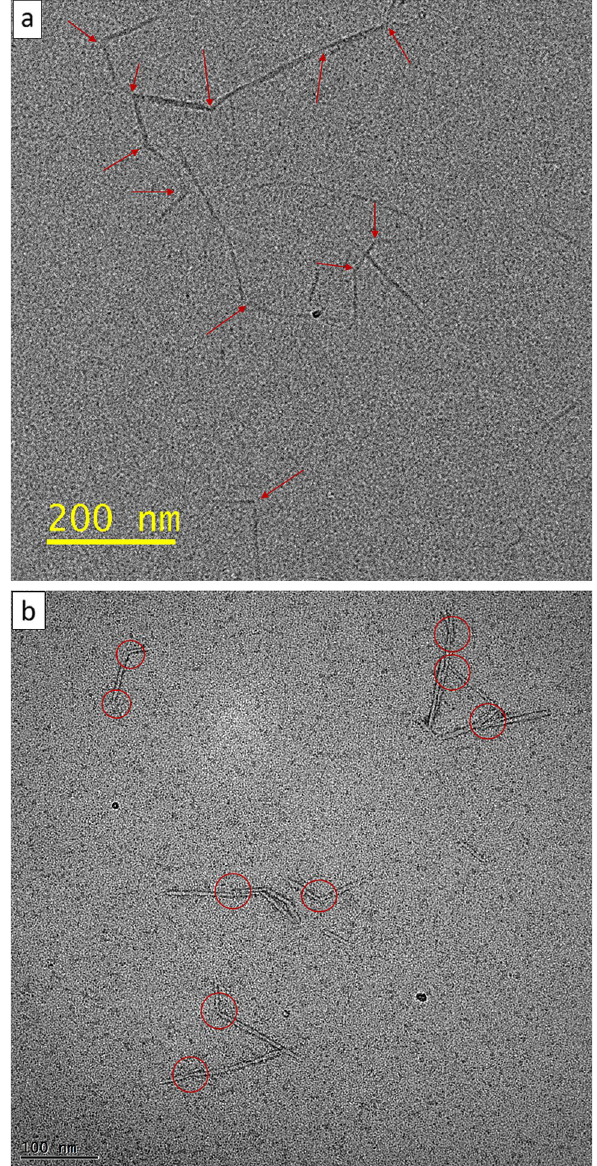
Figure 2. ( a ) HR-TEM images (without staining but under cooling) of TEMPO-CNFs after heated in 150 °C saturated water vapor for 2 h. We observed TEMPO-CNFs curved and twisted (pointed by red arrows). ( b ) HR-TEM images (negatively stained with 2.0% uranyl acetate) of TEMPO-CNFs after heated in 150 °C saturated water vapor for 4 h. We observed jointed ultrastructures on the heated TEMPO-CNFs (pointed by red